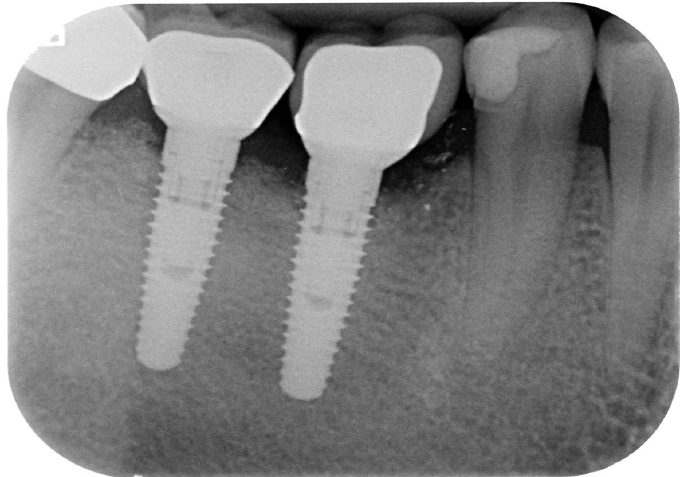
Figure 6. Follow-up radiograph (38 months). Int. J. Environ. Res. Public Health 2021 , 18 , x FOR PEER REVIEW